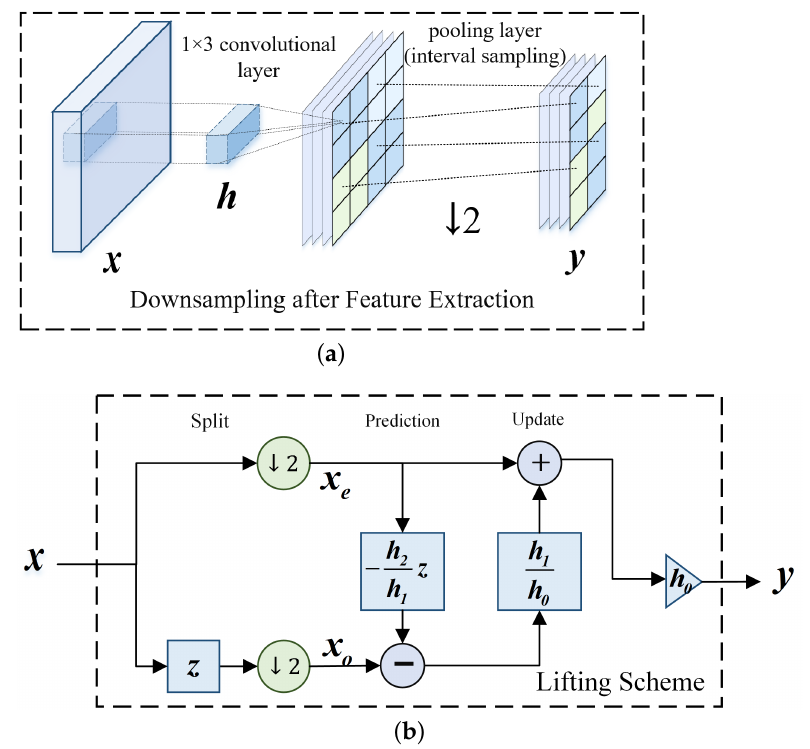
Figure 2. The method of downsampling after extraction is generally implemented with a vanilla con- volutional layer and a pooling layer, while the lifting scheme is another alternative implementation. The symbols x , h , and y denote the input signal, convolutional kernel, and output signal, respectively. The lifting scheme contains three steps: split, prediction and update. These two methods have the same x and y theoretically, and h = [ h 0 , h 1 , h 2 ] in ( a ) is transformed into the prediction and update operators as showned in ( b